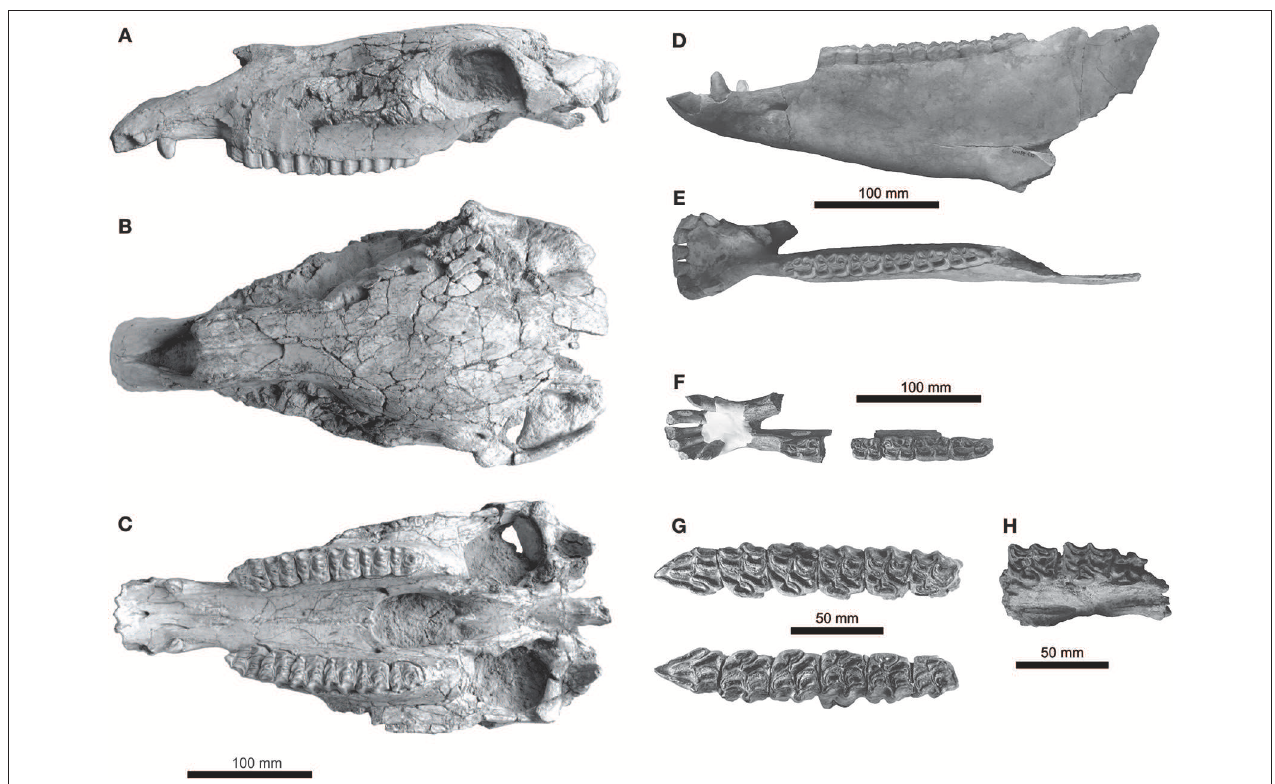
FIGURE 3 | Equus conversidens from southern Mexico. UMPE 077, skull in (A) lateral, (B) dorsal, and (C) palatal views. UMPE 620, left mandible in (D) lateral and (E) dorsal views. IHNFG-2856, left mandible in (F) dorsal view. IHNFG-2685, upper teeth series in (G) occlusal view. UMPE 008, left maxillary with DP4- M2 in (H) occlusal